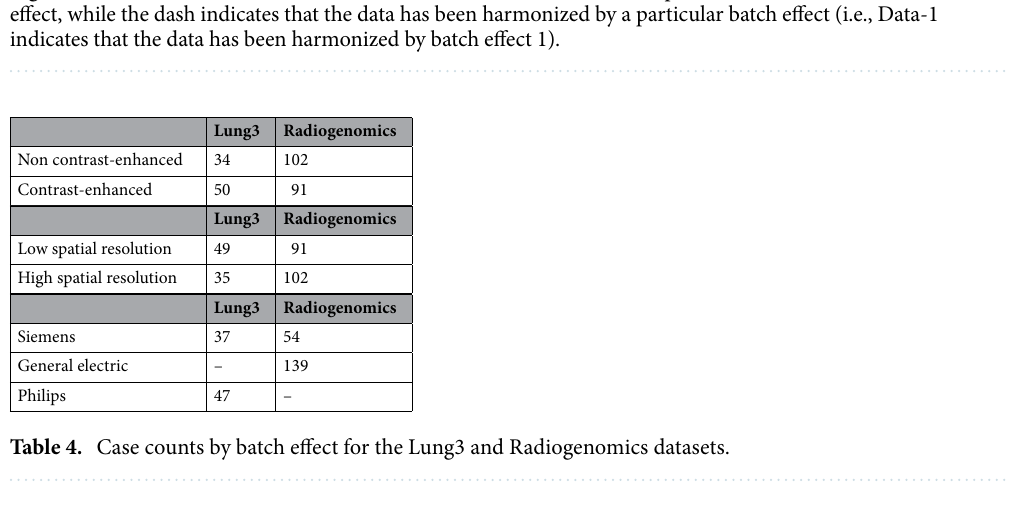
(Table 4). In the Lung3 dataset, the clinical variables of death event, histology, stage, gender, and survival were protected. In the Radiogenomics dataset, the clinical variables of death event, histology, sex, smoking status, and days were preserved.